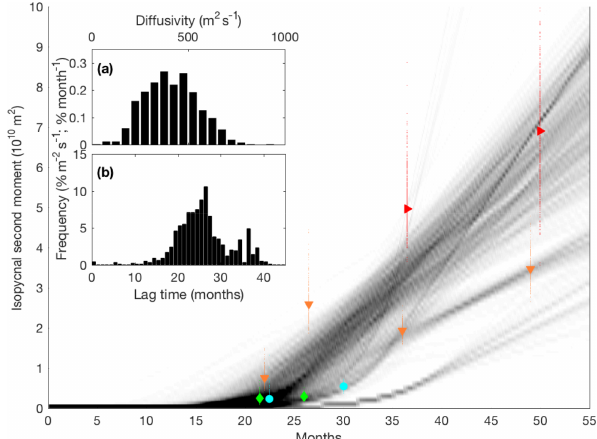
Figure A1. As in Fig. 8, but with the shading showing the density of solutions from 1000 best fits of the Garrett (1983) model where the sections are randomly subsampled. The two subplots show the distribution of isopycnal mixing coefficients (a) and lag times (b)